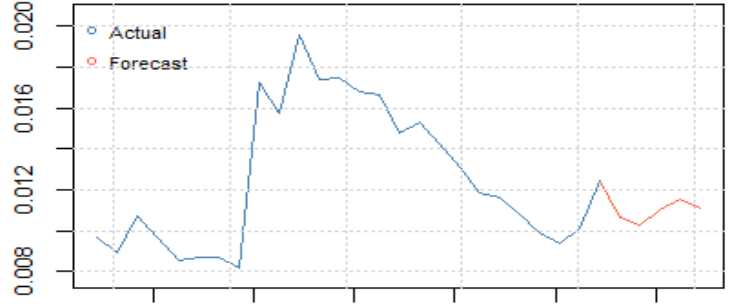
Figure.4. Short-term (5 days) Forecasting using GARCH Source: Author’s own elaboration